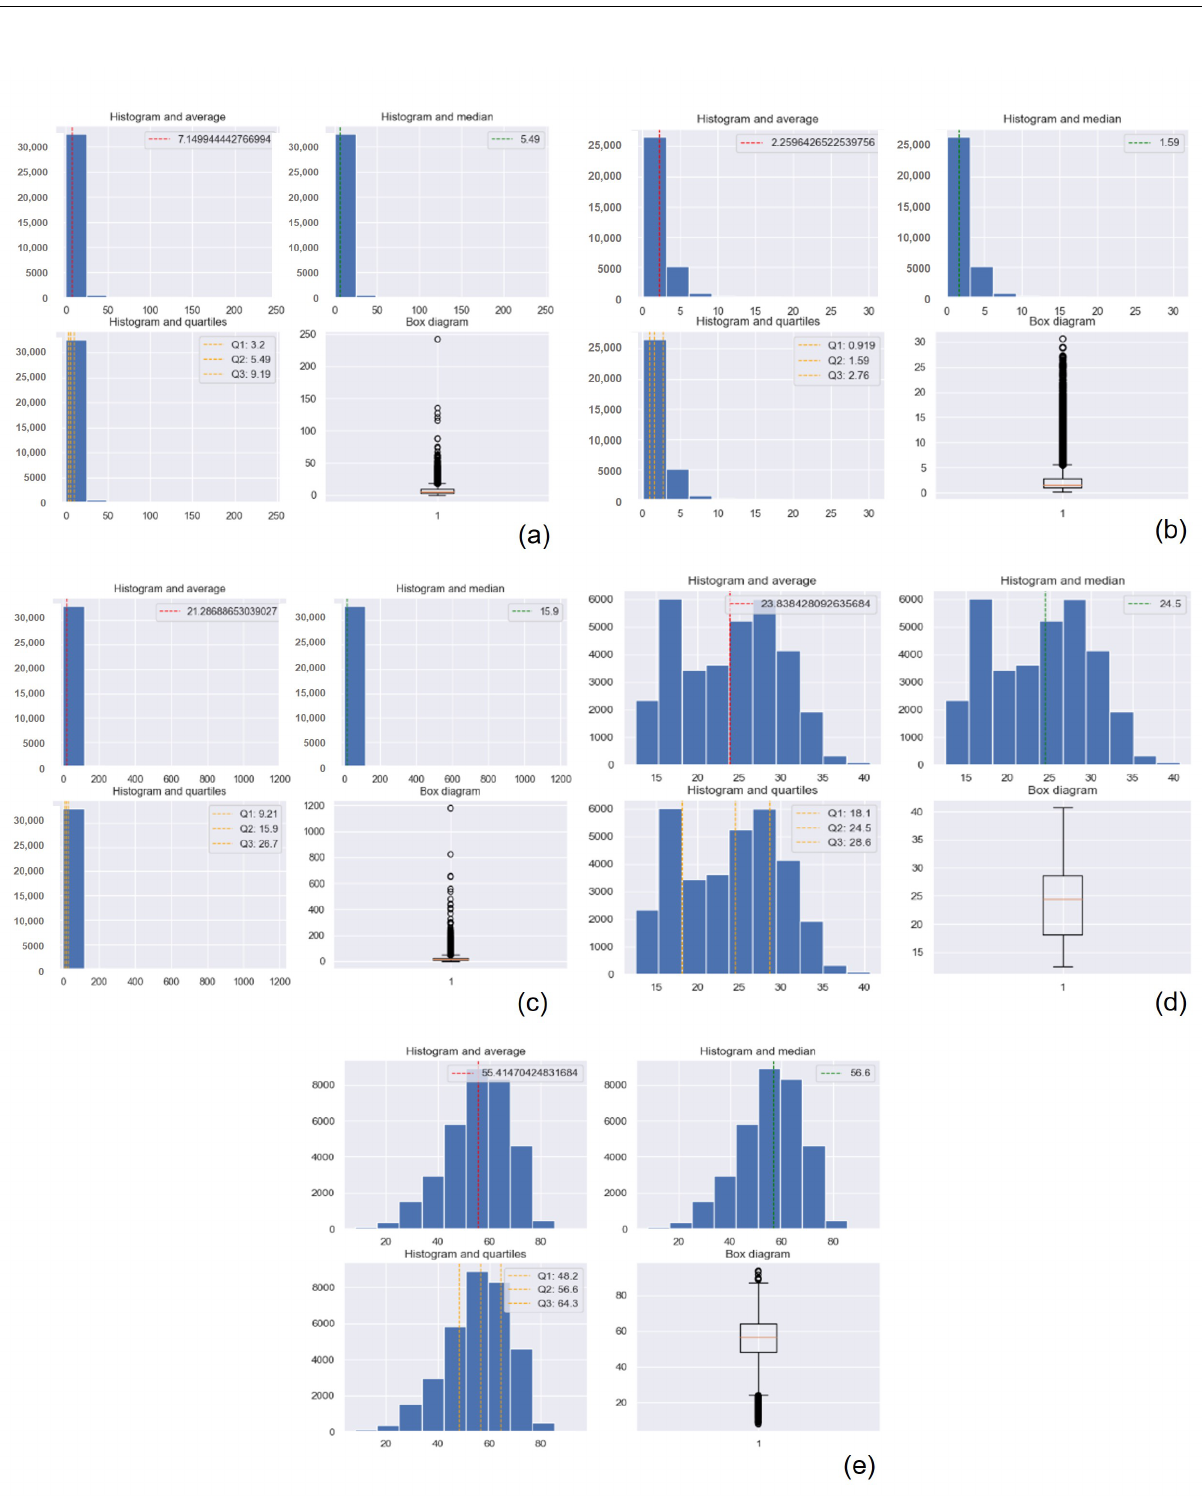
Figure A2. Statistics for ( a ) PM 2.5 ( b ) PM 1 ( c ) PM 10 ( d ) Temperature and ( e ) Humidity for particulate matter measuring device #